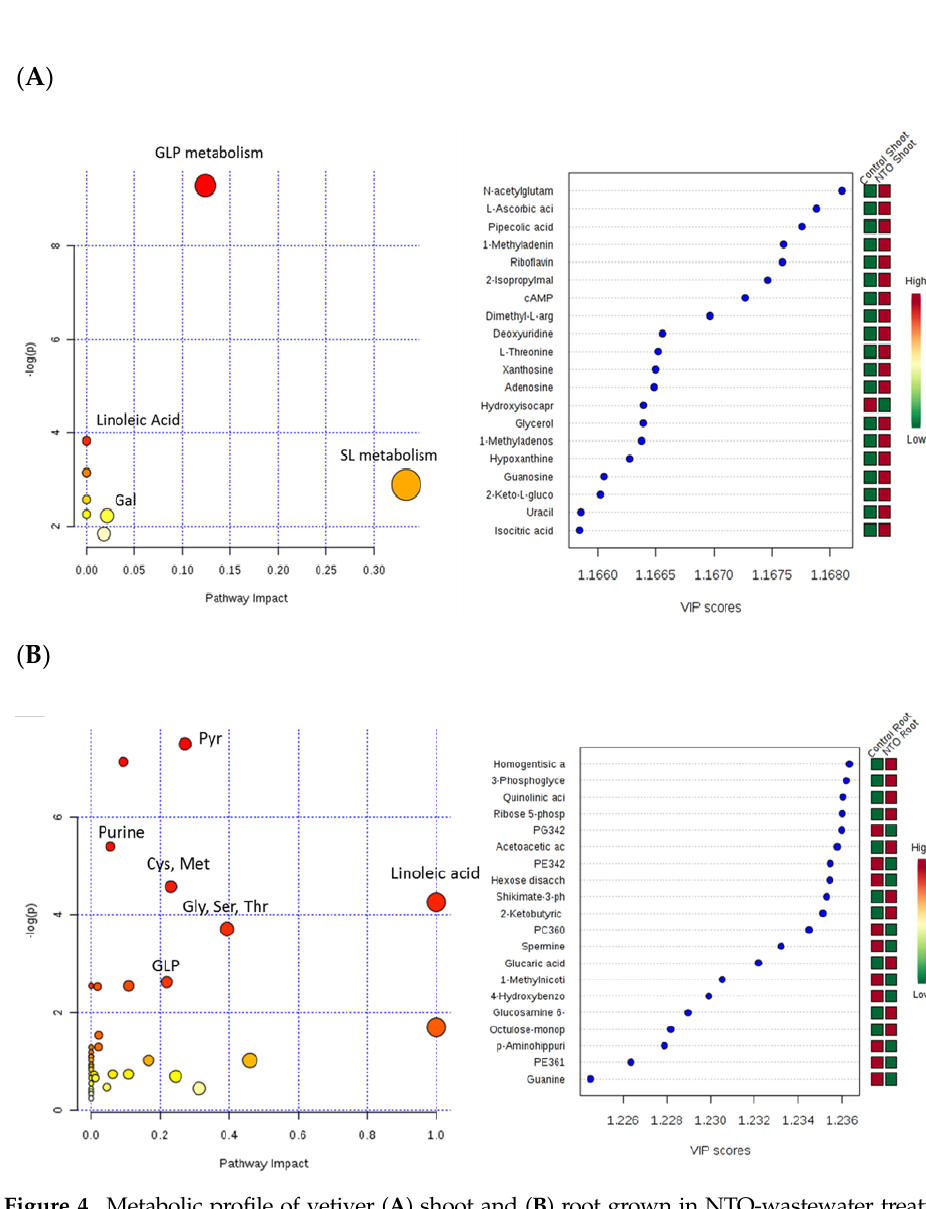
Figure 4. Metabolic profile of vetiver ( A ) shoot and ( B ) root grown in NTO-wastewater treatments (NV) compared to control plants grown in a nutrient medium. GLP metabolism—glycerophospholipid metabolism, Gal—galactose metabolism; Linoleic Acid—linoleic acid metabolism; SL metabolism— sphingolipid